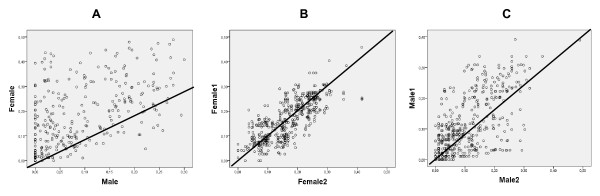
Recombination frequency correlations between turbot maps. (A) between sexes; B) among families within female; C) among families within male. Numbers 1 and 2 in the legend of axis in females (B) and males (C) represent whatever mother or father, respectively, of the reference mapping families.